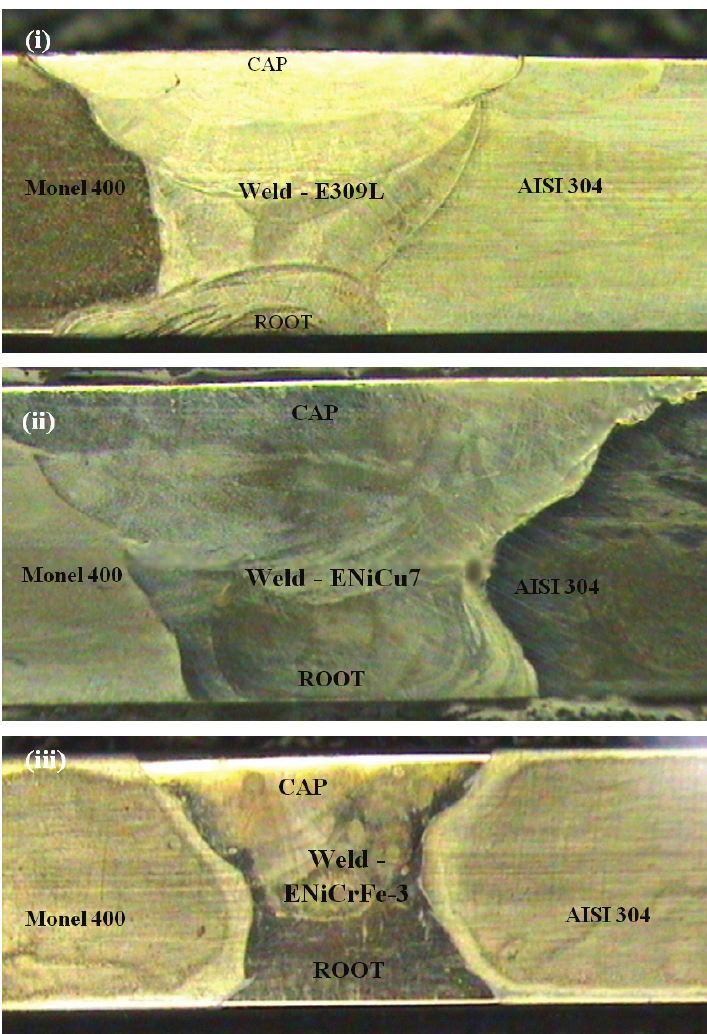
Figure 2. Macro-photographs of the PCGTA welds of dissimilar Monel 400 and AOSO 304 using (i) ER309L (ii) ERNiCu-7 and (iii)